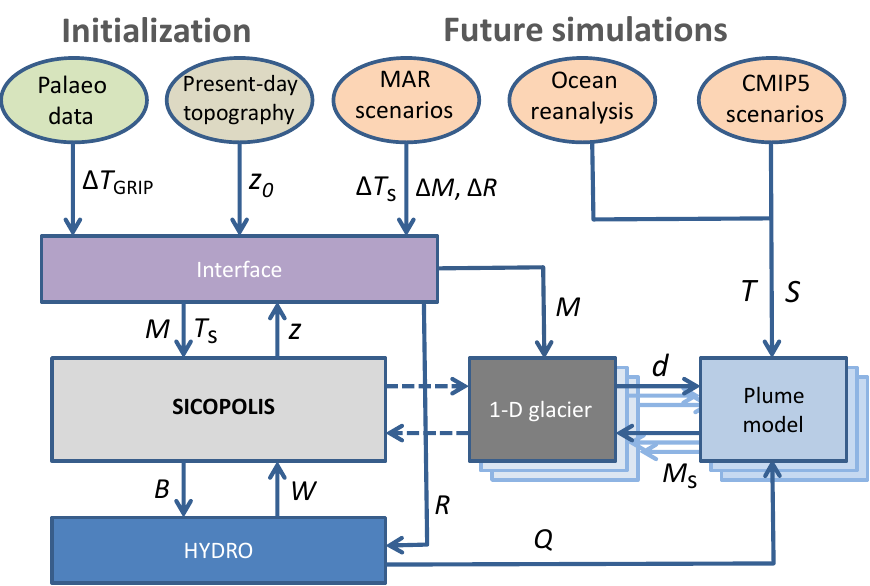
Figure 1. Flow diagram of the model IGLOO and the interaction between its components. The 1-D outlet glacier and plume models are generic models, i.e. they can be applied to each outlet glacier of the Greenland ice sheet. Coupling between the ice sheet model and the generic outlet glacier models is not implemented yet, denoted by dashed arrows. In this paper, coupling between HYDRO and the plume model is offline. Simulations with the coupled generic outlet glacier models and plume models, as well as details on the coupling between them are described in Beckmann et al. (2018a). The exchange variables are explained in Table